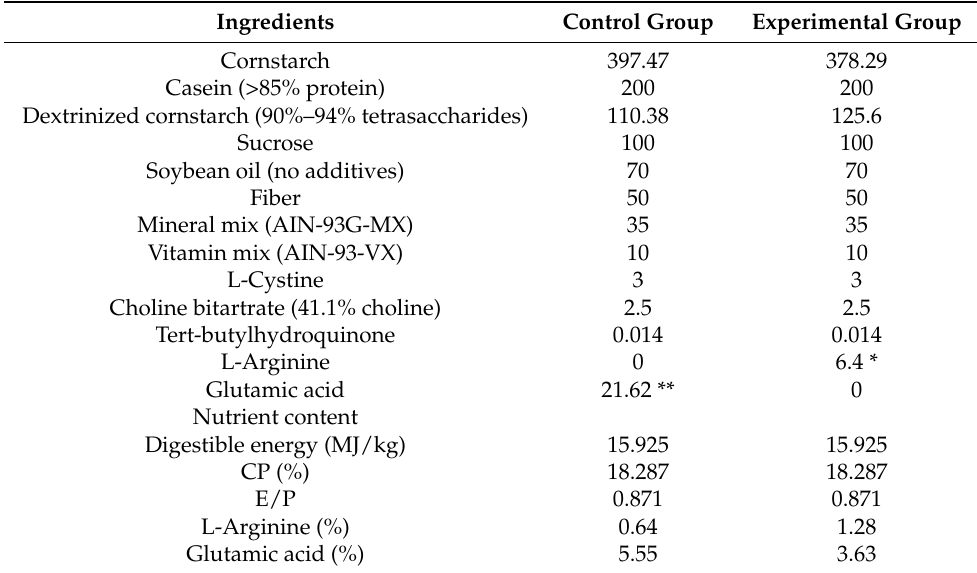
Table 1. Composition of the experimental diets